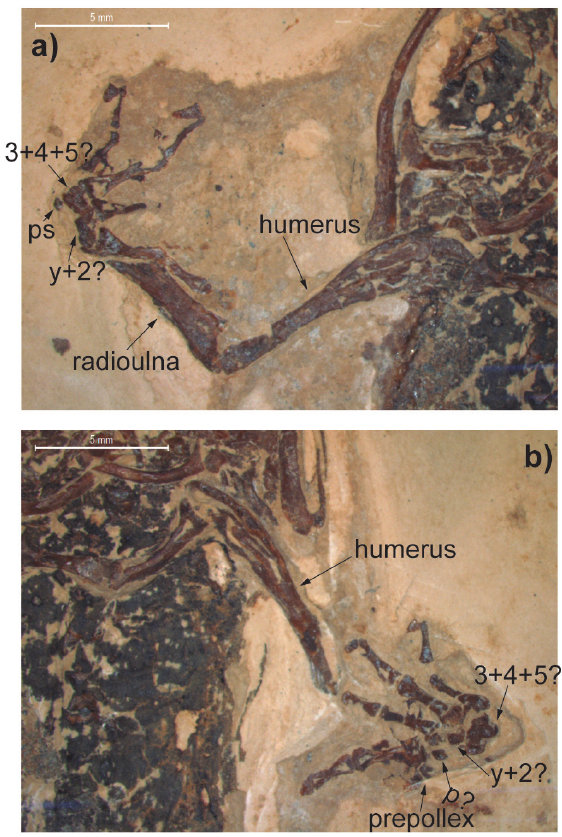
Figure 3. Primaevorana cratensis, holotype (GP/2E-9497) from Crato Formation, Lower Cretaceous (Aptian), region of Nova Olinda, Araripe Basin, Ceará state, Northeastern Brazil. a) Right forelimb; b) Left forelimb. Photographs by Ivan Nunes. Abbreviations: 3+4+5: distal carpals 3+4+5; ps: palmar sesamoid; y+2: element y + distal carpal 2; p: proximal element of the